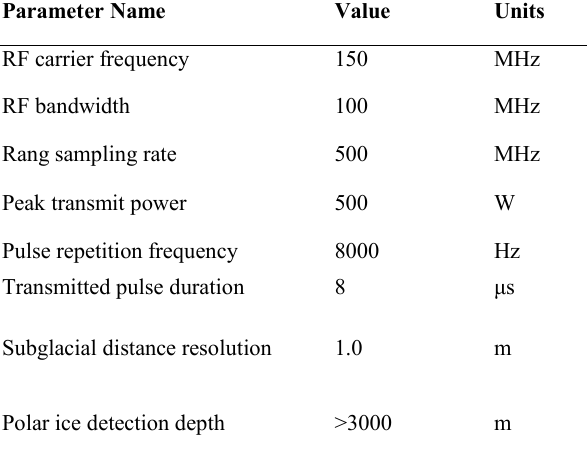
Table 1. The main technical parameters of